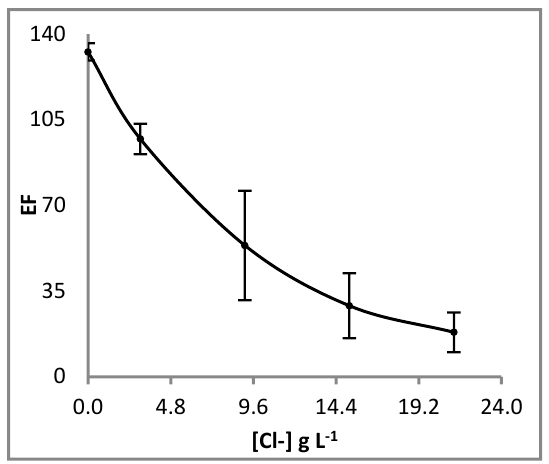
Figure 7. Effect of chloride concentration in the sample on the enrichment factor. Liquid membrane: Cyanex ® 272 1.06 M in dihexyl ether. Extraction time: 120 min. Fiber length: 6 cm. Acceptor solution: HNO 3 0.04 M.